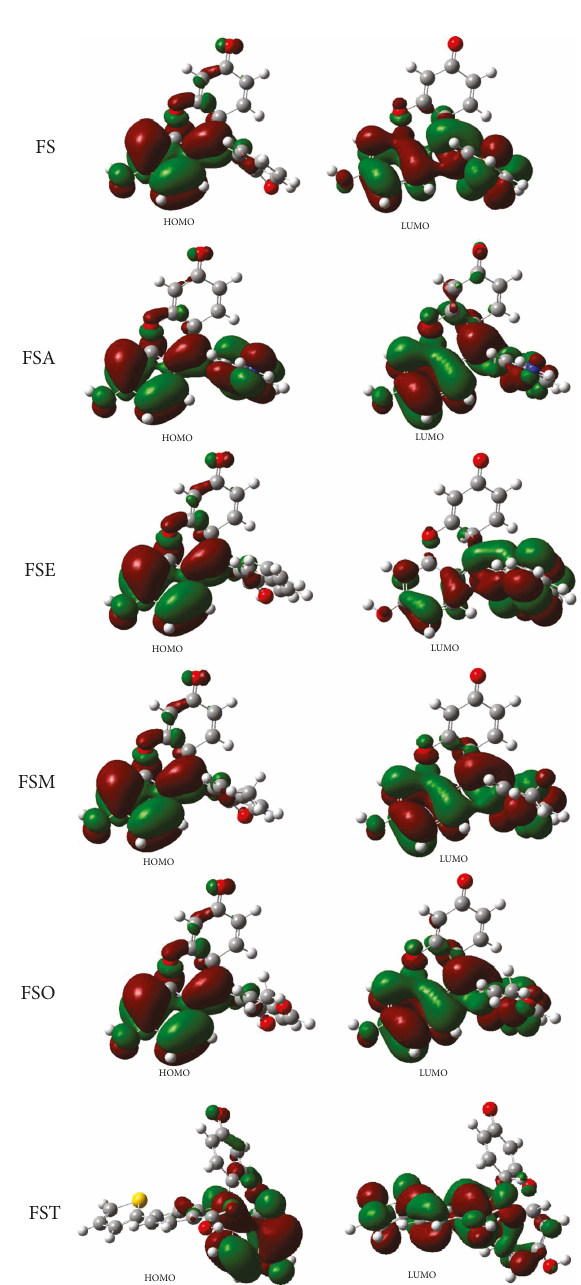
Figure 3: The HOMO and LUMO orbitals of the studied dye